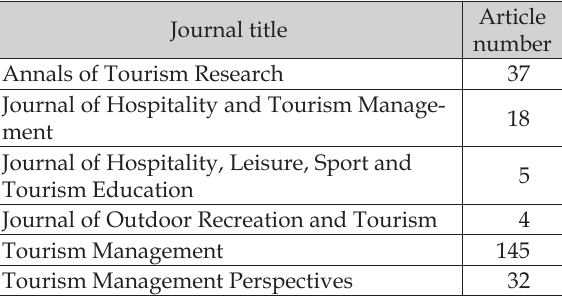
Table 1. Numbers of journal articles by